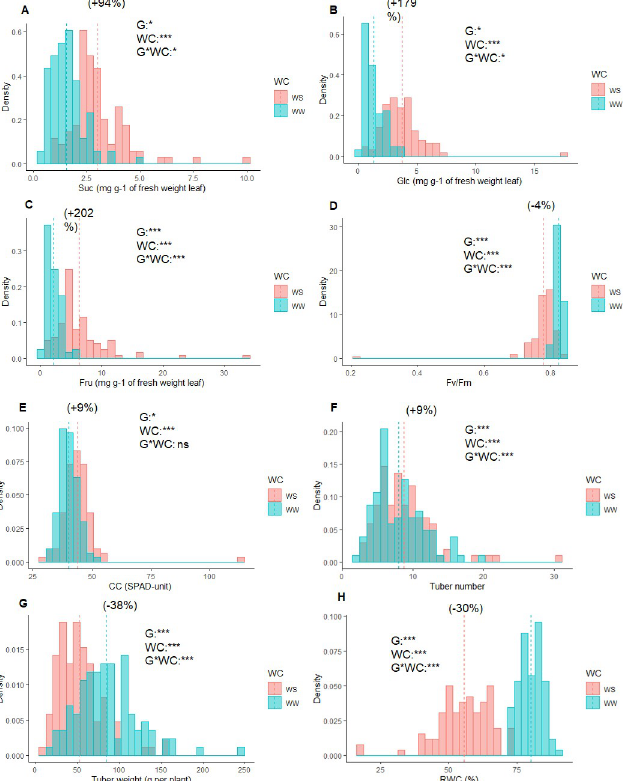
Fig 1. Histogram of phenotypic values distribution analysis of the studied variables in 104 diploid genotypes under well-watered and water deficit conditions. a.) Sucrose (Suc), b.) Glucose (Glc), c.) Fructose (Fru), d.) the maximum quantum efficiency of PSII (F v /F m) , e.) Relative chlorophyll content (CC), f.) Tuber number (TN), g.) Tuber fresh weight per plant (TW) and h.) Relative water content (RWC). The vertical lines in the histograms show population mean values in well-watered condition (green) and water-deficit conditions (red) conditions, and values in parentheses represent the significant percentage change (+, increase;–, decrease) in water-deficit conditions over the well-watered. Levels of significance for genotype (G), water conditions (WC), and their interaction (G � WC) effects from ANOVA are given in the histograms ( ��� p � 0.0001; �� p � 0.001; � p � 0.05; ns, p > 0.05.